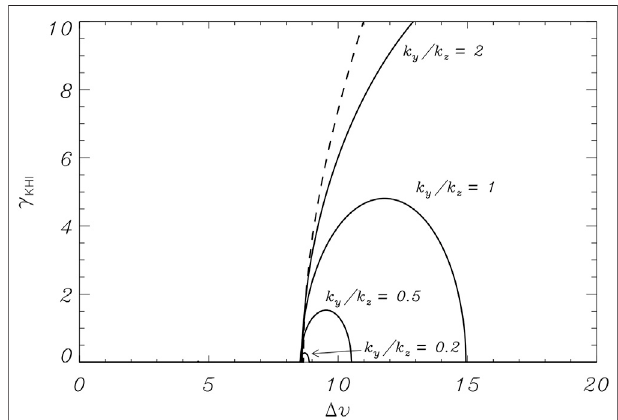
FIGURE 1 | KHi growth rate in normalized units as a function of the dimensionless shear fl ow velocity in a fully ionized plasma interface. The dashed line corresponds to the incompressible case. The various solid lines correspond to the compressible case for different values of the ratio of the perpendicular, k y , to the longitudinal, k z , components of the wavevector (indicatedwithinthe fi gure).CompressibilitycanentirelysuppresstheKHifora suf fi ciently small value of the ratio k y / k z . Adapted from Soler et al. (2012b). © AAS. Reproduced with